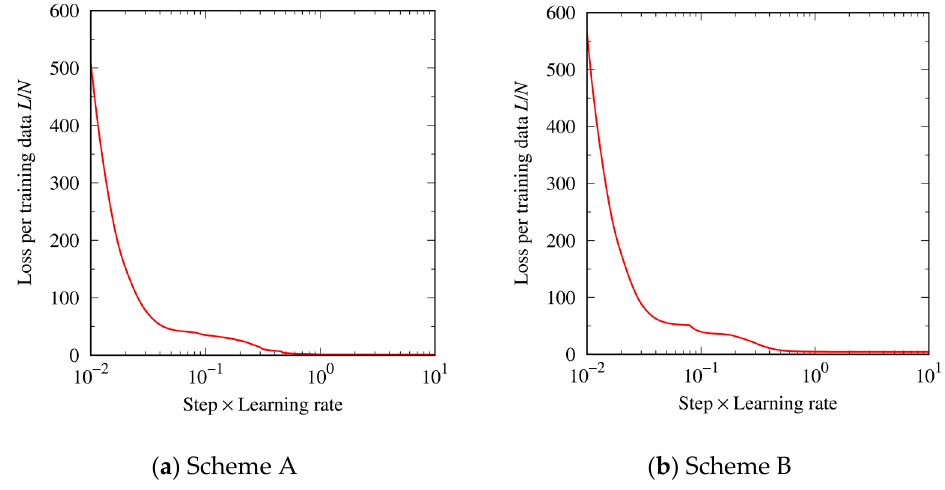
Figure 3. Loss function in ( a ) Scheme A and ( b ) Scheme B. The horizontal axis shows the value obtained by Step (max step is 10 8 ) × Learning rate (10 − 7 ). The vertical axis shows the loss per training data of the ANN model ( N = 240).